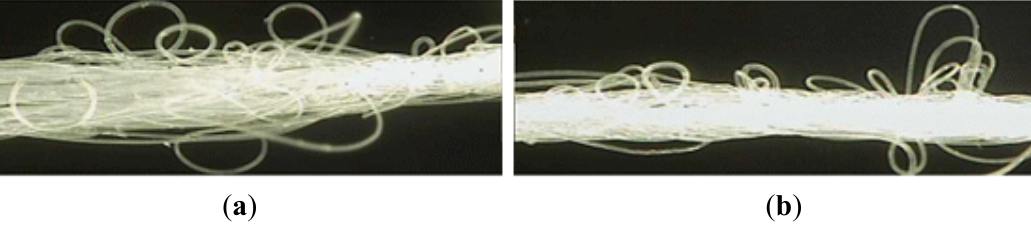
Figure 4. PA fiber processed by air textured yarn (Optical microscope ×8). ( a ) PA fiber before temperature treatment; ( b ) PA fiber after temperature treatment.